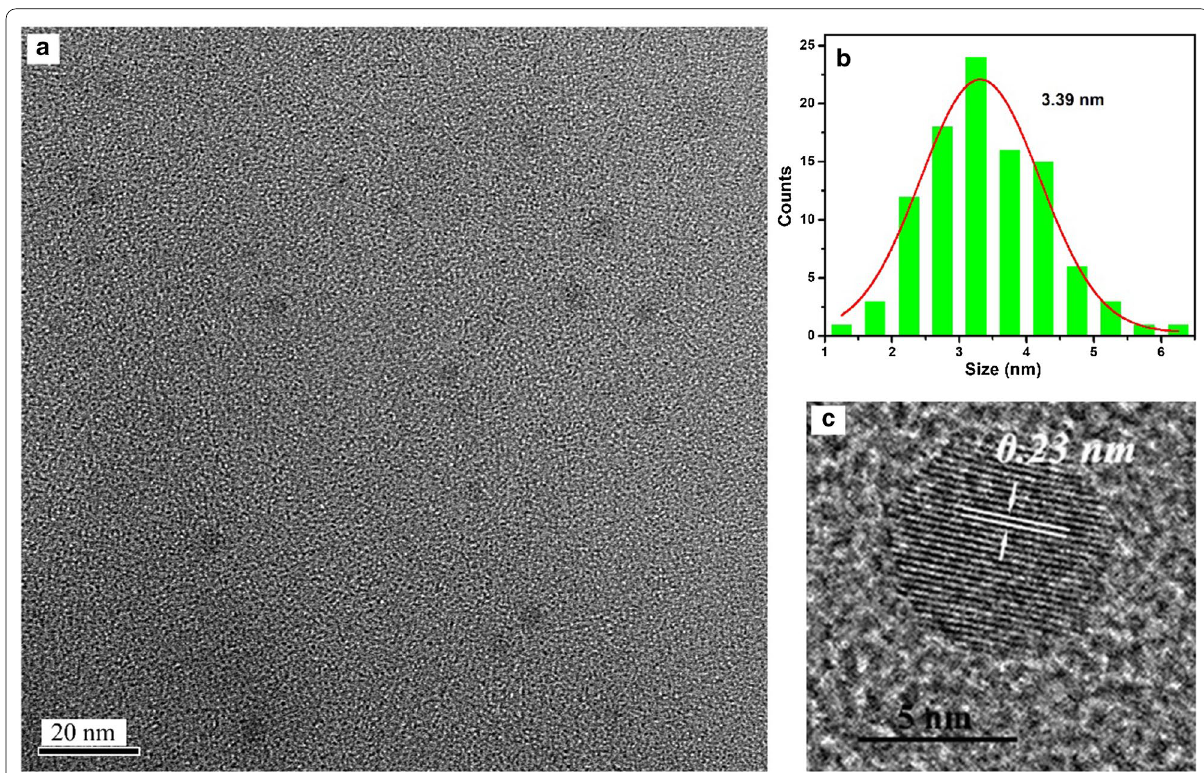
Fig. 2 a TEM images of A m -CDs, b the particle size distribution histograms, and c HR-TEM